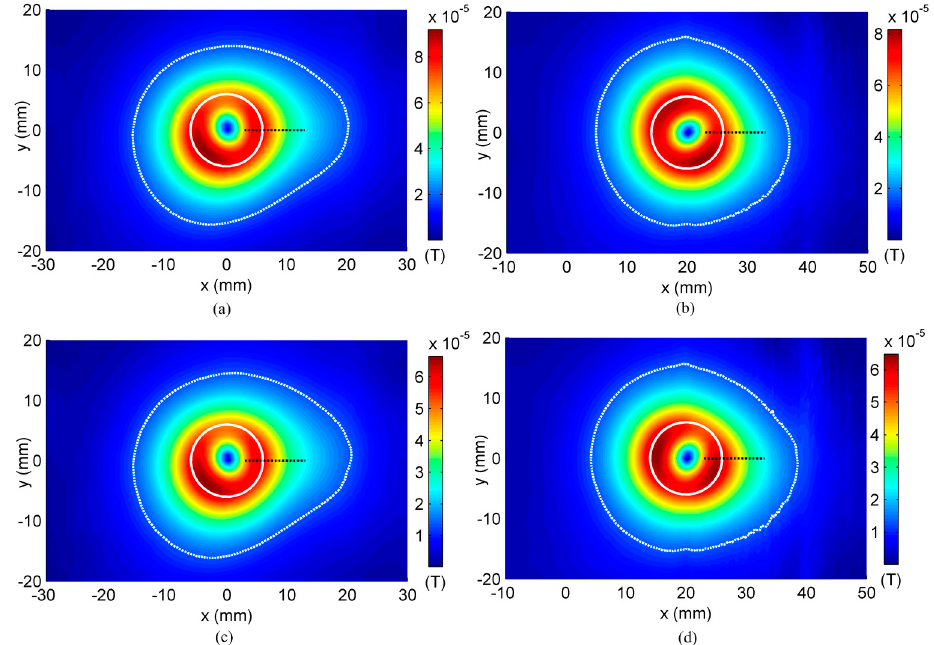
Figure 10. Simulation results for cases: ( a ) conventional coil, rivet center located at x = 0 mm; ( b ) conventional coil, rivet center located at x = 20 mm; ( c ) optimized coil, rivet center located at x = 0 mm; ( d ) optimized coil, rivet center located at x = 20 mm.